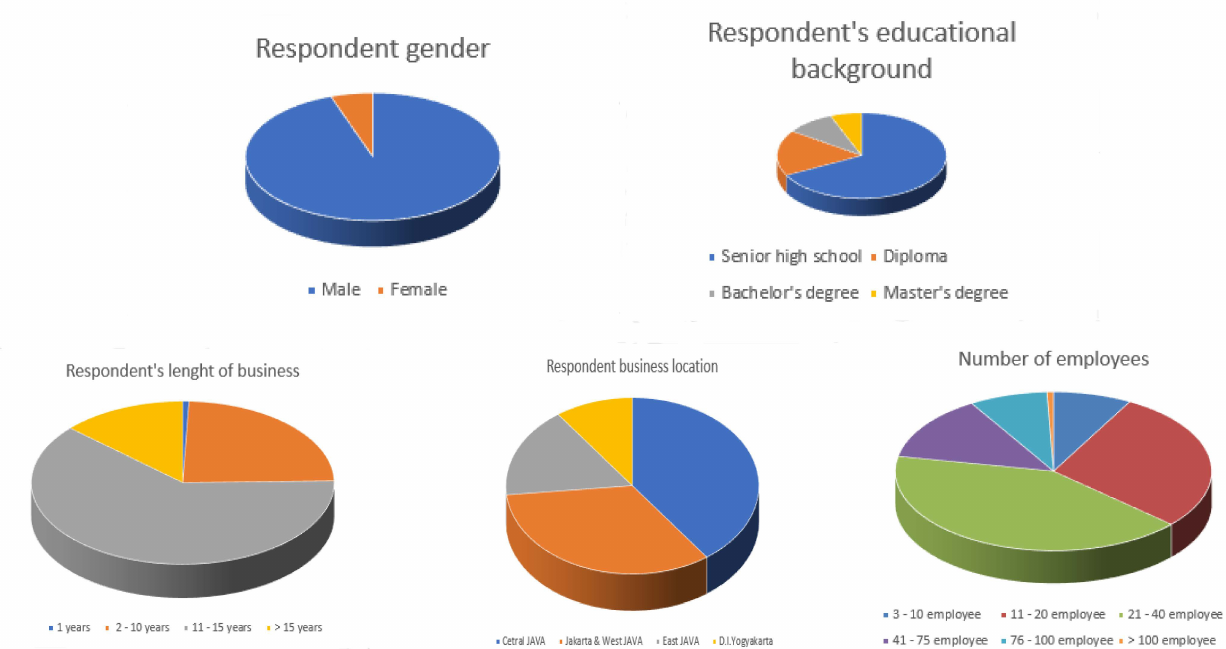
Figure 2. Characteristics of